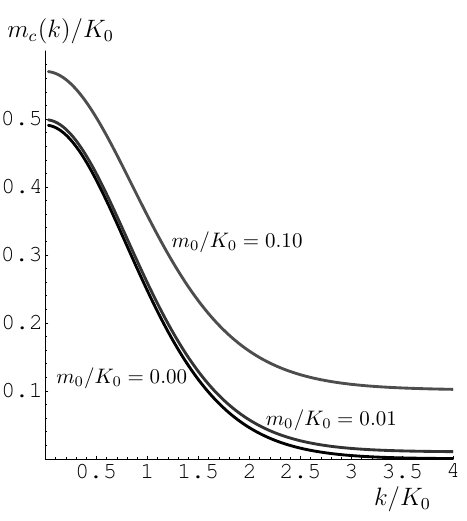
Figure 2. The dependence [20] of the constituent quark mass m c ( k ) on the current quark mass m 0 .